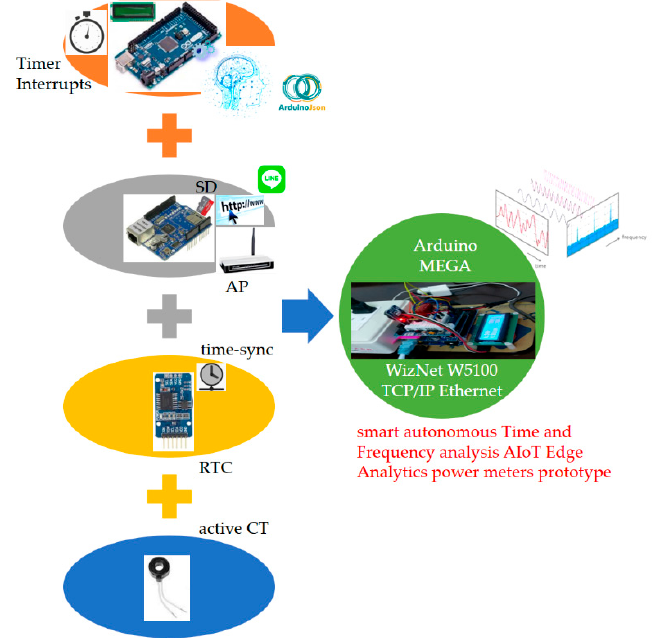
Figure 4. Generic three-tier architecture of fog-cloud analytics.